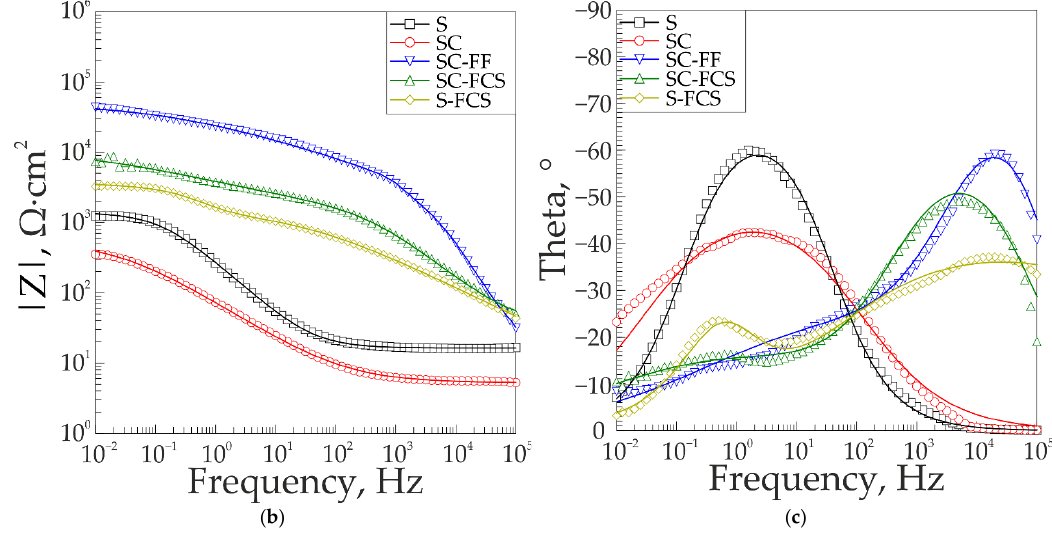
Figure 8. Nyquist ( a ) and Bode plots ( b , c ) for the samples with the different means of SPTFE deposition.